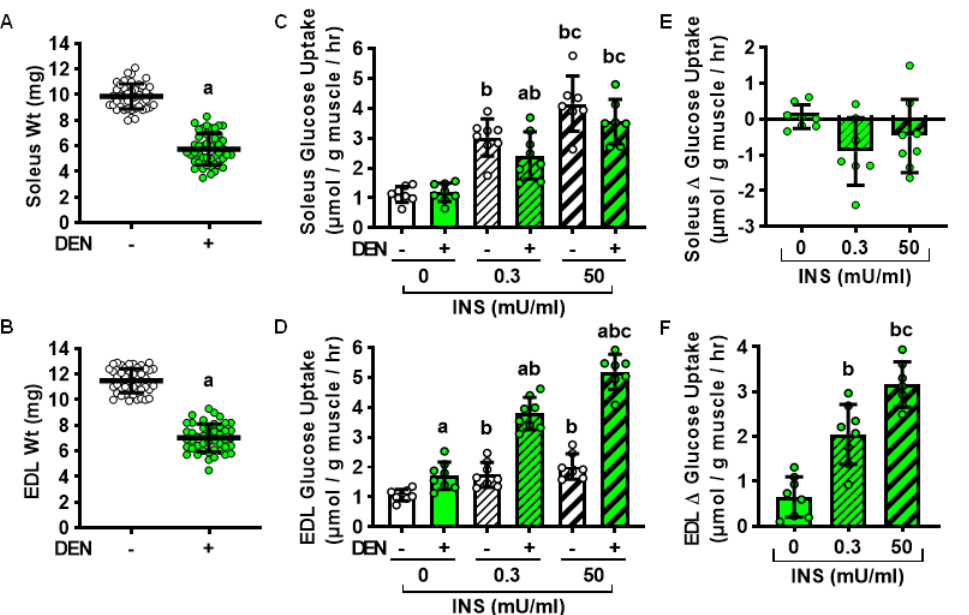
Figure 1. Long-term denervation (DEN) elicits sustained impairments in insulin sensitivity in soleus but not extensor digitorum longus (EDL) muscles. In male wild-type mice, hindlimb muscle DEN was induced in one leg for 28 days while the contralateral leg was sham-operated (-). ( A ) Soleus and ( B ) EDL muscle weights. ( C , D ) Ex vivo muscle [ 3 H]-2-deoxy- D -glucose uptake was assessed in the presence of 0, 0.3 or 50 mU/ml insulin (INS). ( E , F ) DEN-induced change (Δ) in muscle glucose uptake relative to the contralateral control muscle. Statistical significance was defined as p < 0.05 and determined using paired t -tests (Panels ( A , B ); n = 44–46 muscles/group), two-way ANOVAs and Tukey’s post-hoc analysis ( C , D ; n = 7–8 muscles/group), or one-way ANOVAs and Tukey’s post-hoc analysis ( E , F ; n = 7–8 muscles/group). Significance is denoted by ‘a’ vs. -, ‘b’ vs. 0 mU/mL INS, and ‘c’ vs. 0.3 mU/mL INS.